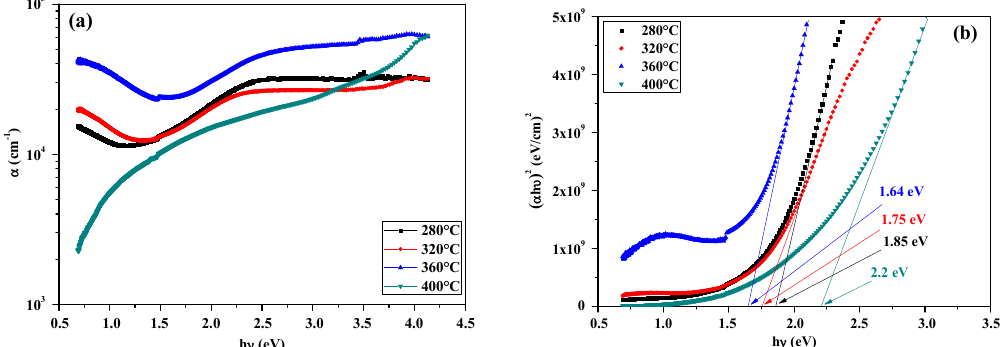
Figure 2. ( a ) Variation of absorption coefficient ( α ), and ( b ) variation of ( α h ν ) 2 versus photon energy (h ν ) of CMTS thin films grown at different substrate temperatures.